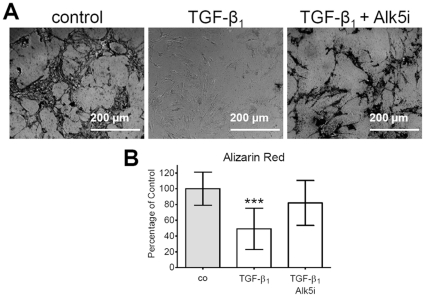
TGF-β1 inhibits formation of mineralized matrix in primary human osteoblasts.Primary human osteoblasts cultured in differentiation medium with 5 ng/ml hr TGF-β1 with or without 20 nM SB431542 for 20 days. (A) Representative picture for von Kossa staining for mineralized matrix. (B) Quantitative staining of produced mineralized matrix with Alizarin Red. Continuous stimulation of cells with TGF-β1 inhibited formation of mineralized matrix. We could prevent this effect by addition of SB431542. Results are expressed as mean ± standard deviation (N = 5, n = 6). ***p<0.001 in comparison to control conditions.